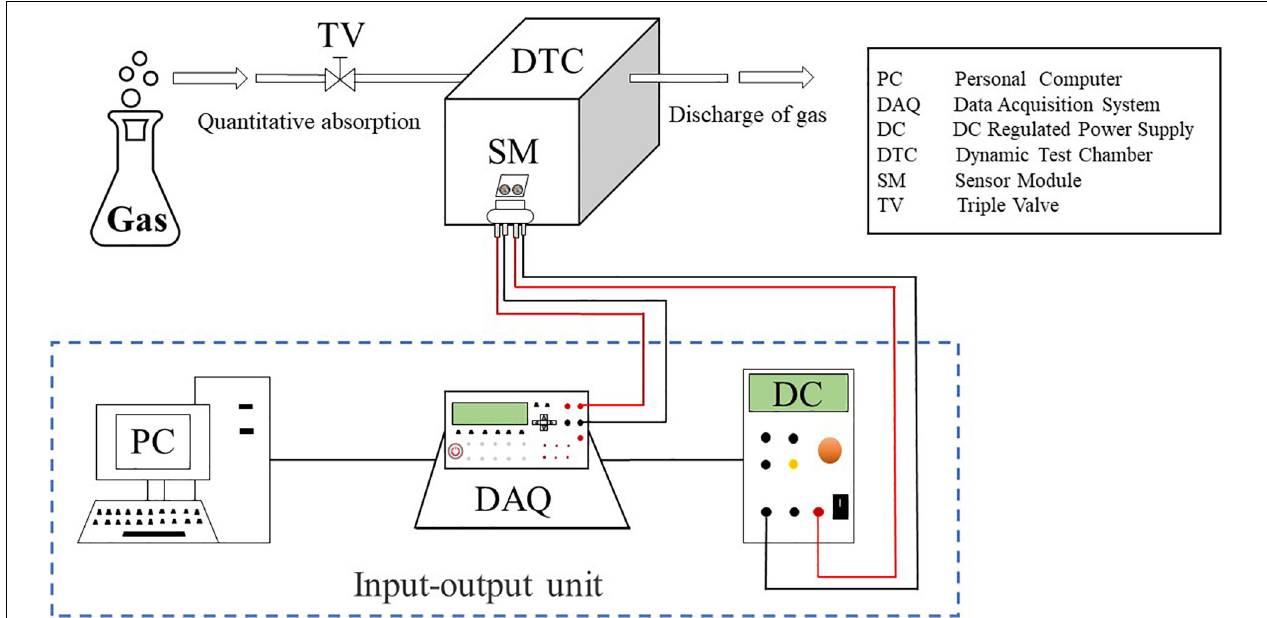
FIGURE 3 | Test system.